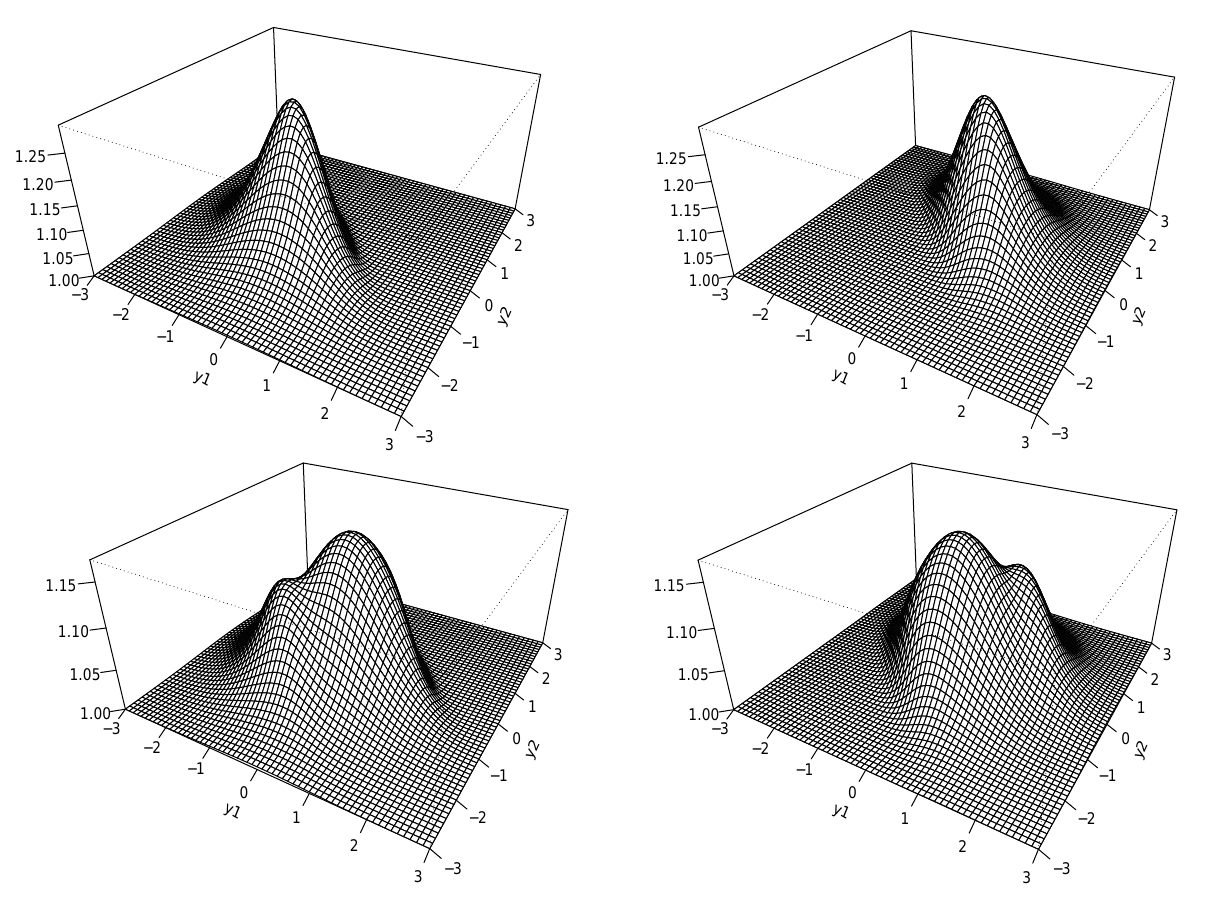
Figure 3. Density for BGSN for: λ 1 = λ 2 = − 3 and α = 1 (upper left panel); λ 1 = λ 2 = 3 and α = 1 (upper right panel); λ 1 = λ 2 = − 3 and α = 5 (lower left panel); λ 1 = λ 2 = 3 and α = 5 (lower right